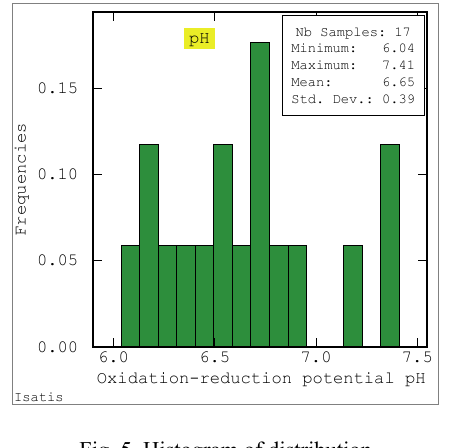
Fig. 5. Histogram of distribution of oxidation-reduction potential pH in underground water for water intake area of Kłodzko (SW part of Poland); data coming from 14 wells + 3 piezometers